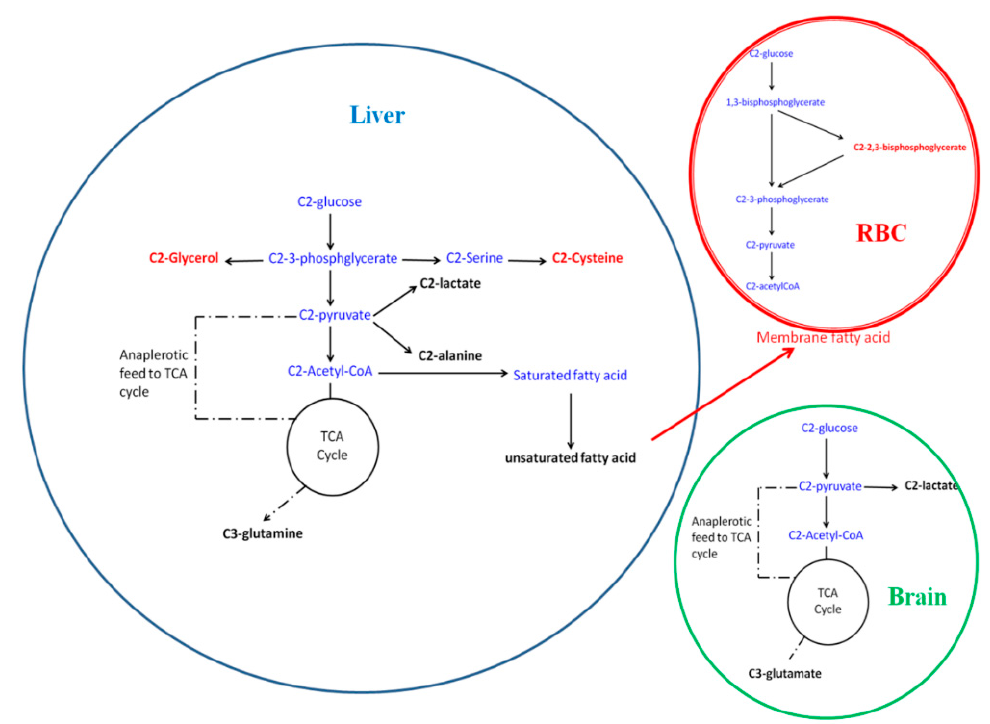
Figure 5. The altered labeling pattern of glucose during early stage malarial infection. The red labels are decreased during the infection, while the black labels are increased. Blue labels are not altered or not picked up in the analysis. The red arrow indicates decreased transport phenomena.